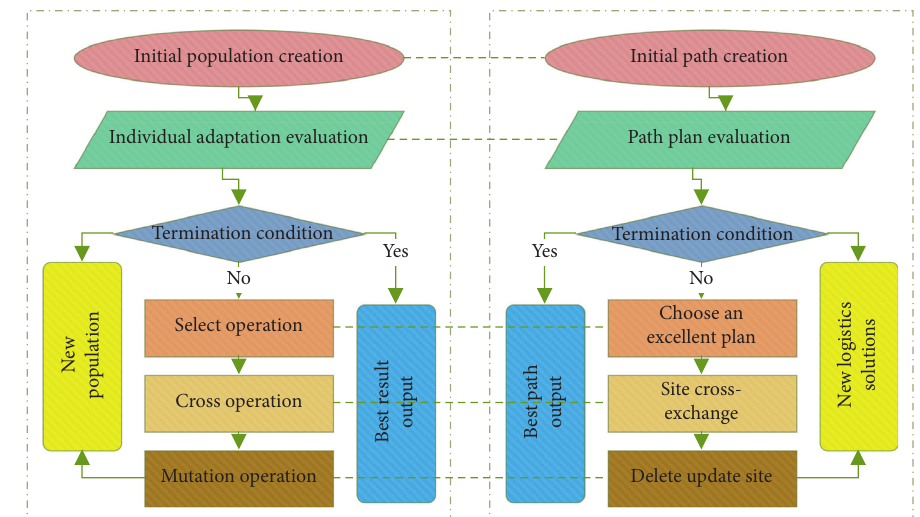
Figure 3: Optimal path optimization.